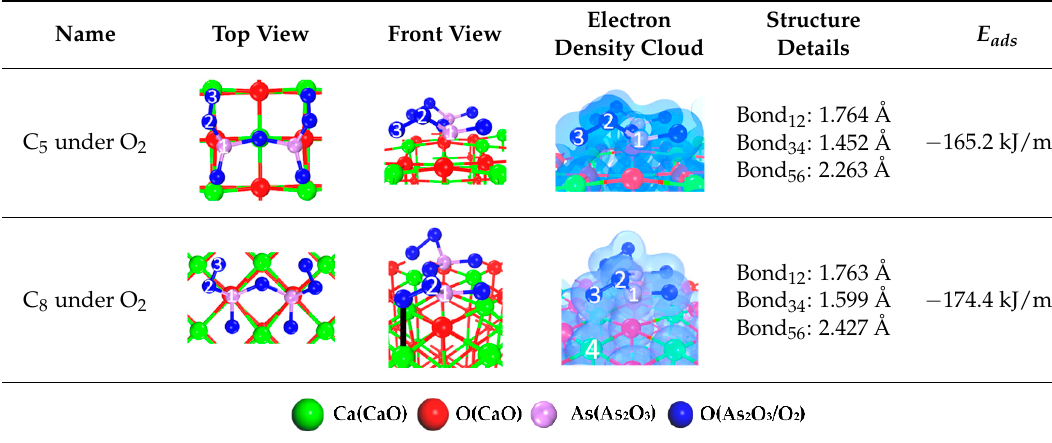
Table 4. Stable chemisorption structures under O 2 atmosphere, adsorption energy, electron density cloud and E ads.